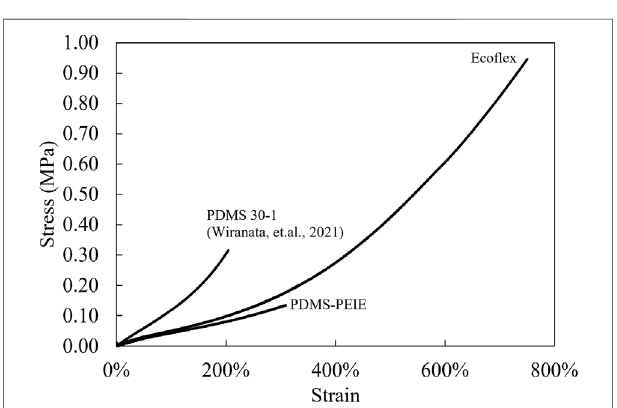
FIGURE 7 | Mechanical characteristics (engineering stress-strain) of the elastomer.